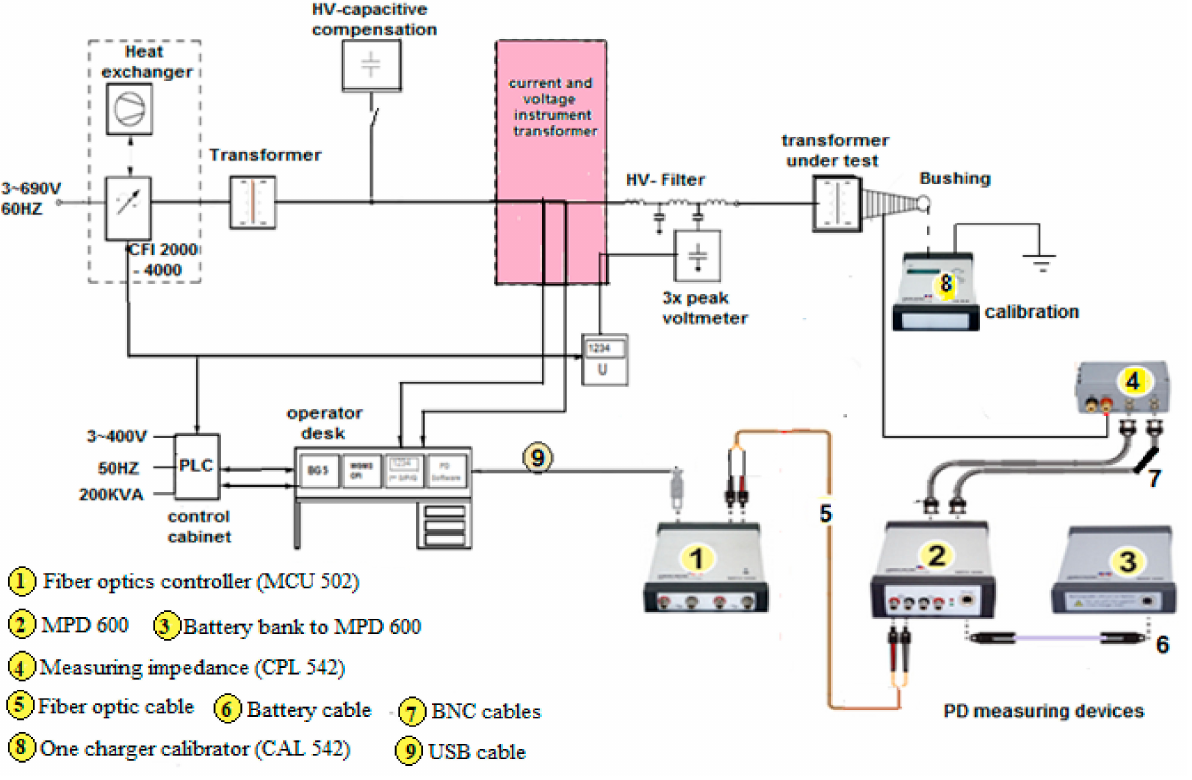
Figure 11. Partial discharge measurements experimental